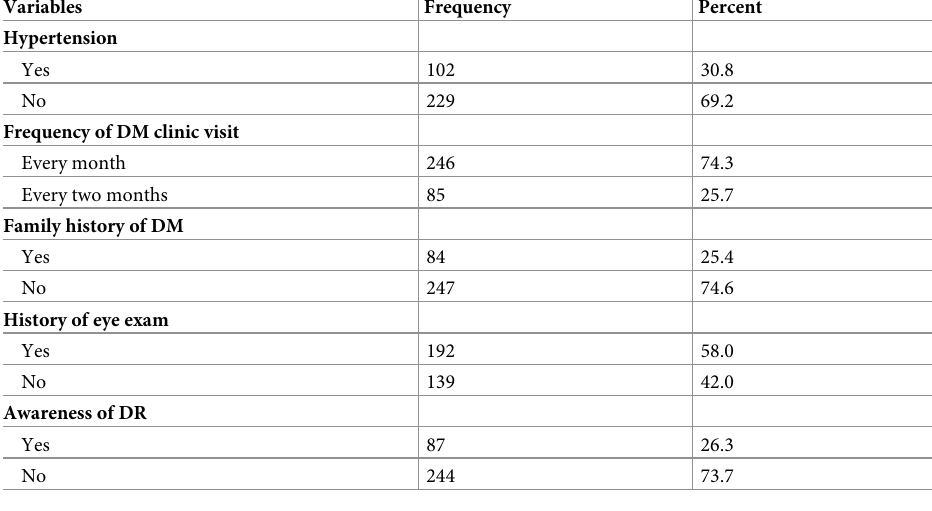
Table 3. Systemic comorbidity, frequency of visit and awareness characteristics of study participants at Debre Tabor General Hospital, Northwest Ethiopia, 2020 (n =